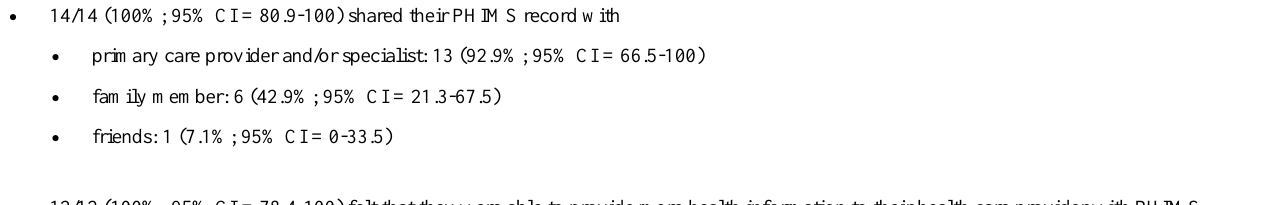
Users for the First 12 Months, No. (%)All Users,